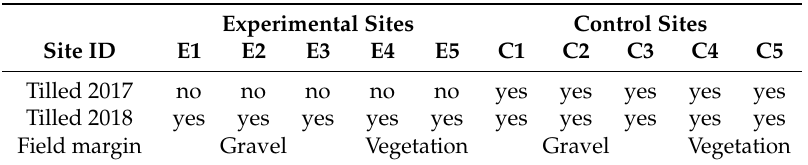
Table 1. Tillage regime and field margin structure of the study sites. The site IDs will be used throughout the manuscript to identify each